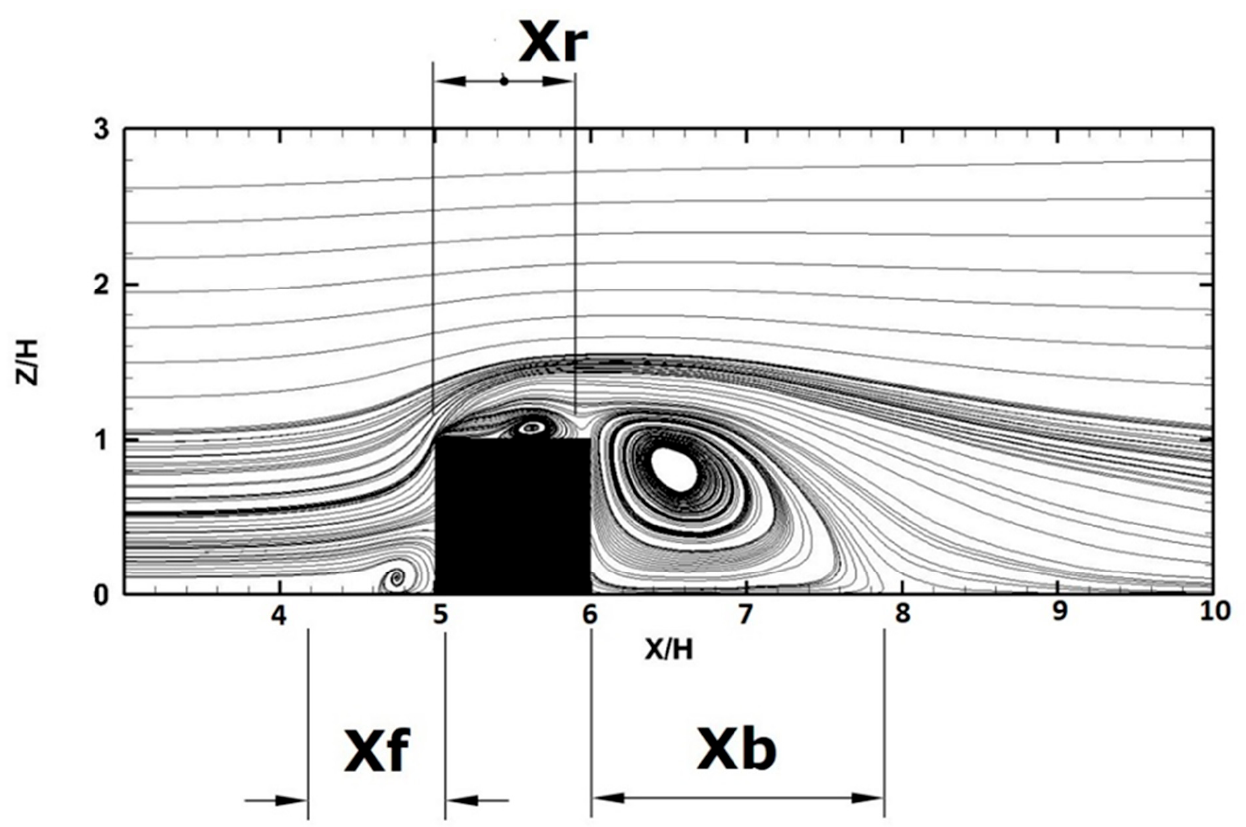
Figure 10. Velocity streamlines of the mean flow field on the symmetry plane of the computational domain for Scenario A.